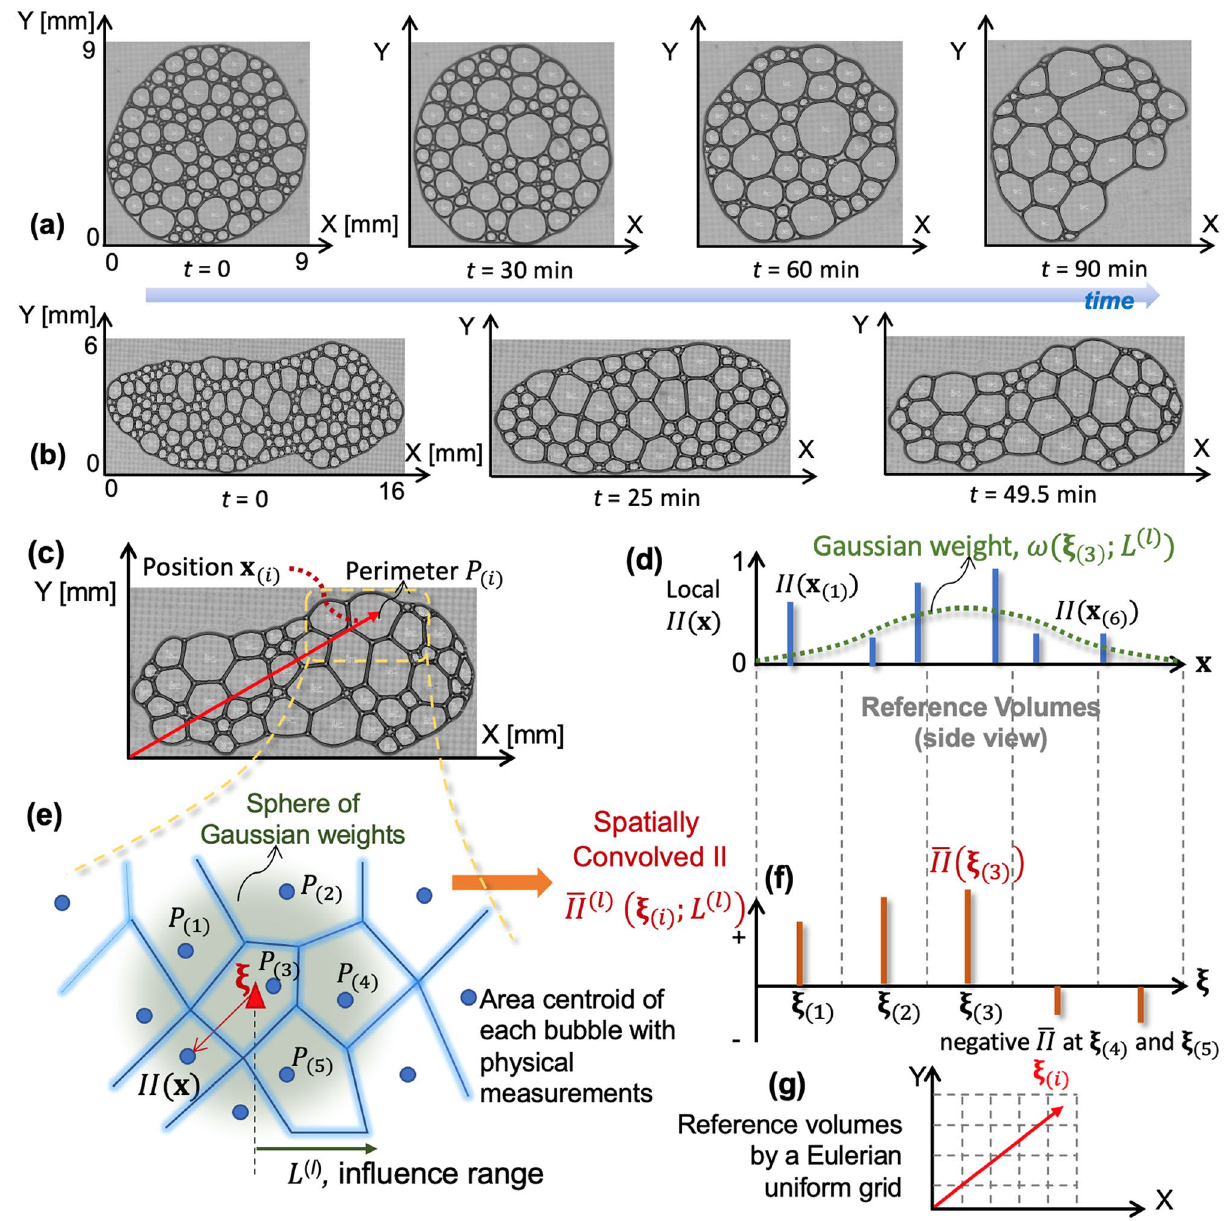
Figure 2. Time-lapsed snapshots of 2D bubble arrays and explanation of the derivation of convolved information index (II): ( a ) Circular bubble array in 9 mm 9 mm domain and ( b ) elongated bubble array in × 16 mm 6 mm domain. Both specimens are placed between two glass plates and the gap is 0.25 mm thick. × The time interval between two images is 30 s; ( c – g ) Derivation of convolved II and reference volume with a fixed Eulerian uniform grid frame; ( c ) snapshot of a bubble experiment and extraction of perimeters and position vectors; ( d ) local II at the areal centroid of each bubble; ( e ) reference volume (centroid ξ ) and spatial convolution; ( f ) spatially convolved II with sign being positive to indicate potential bubble growth and negative to indicate a potential bubble shrinking; ( g ) 2D view of the Eulerian uniform grid system to define reference volumes (i.e., fixed in time unlike the Lagrangian